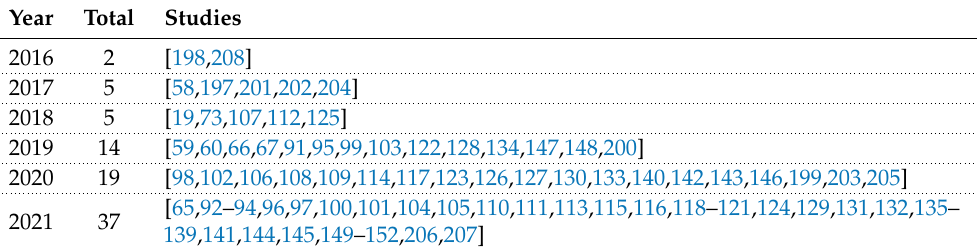
Table 8. Publications per